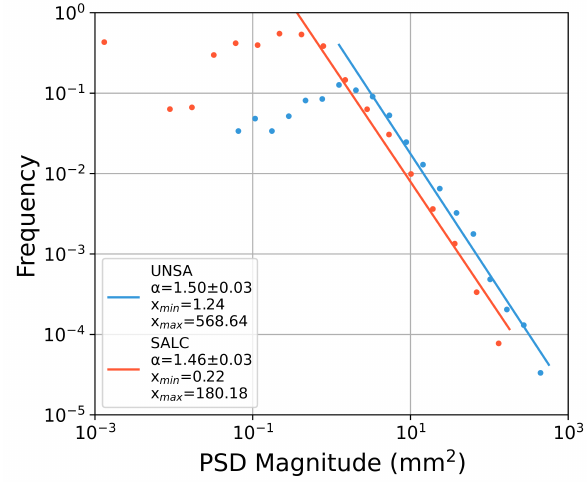
Figure 8. Power-law fitting of the filtered PSDs of the UNSA and SALC stations. The dots indicate the input data that are logarithmically binned using 20 classes. The power-law exponent is described by α , and both exponents are comparable within their standard deviations. The fitting is constrained by the minimum value (x min ) that corresponds to the point/bin, where the frequency magnitude starts to